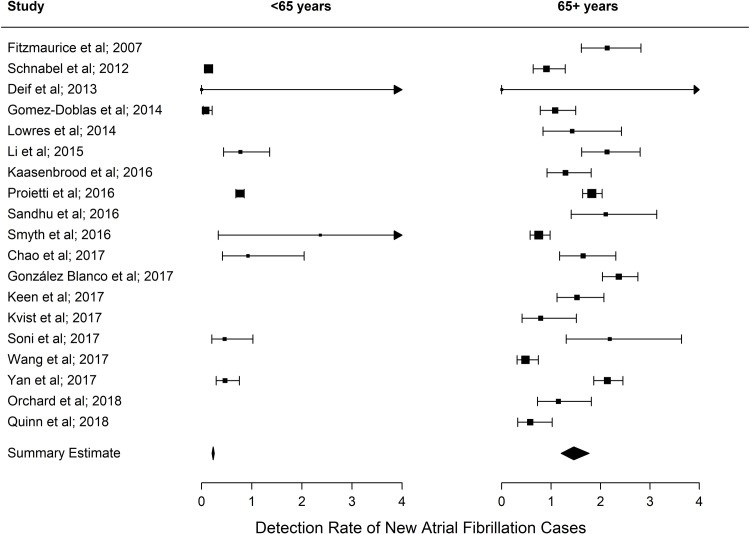
AF detection rate for <65 years and 65+ years.Summary estimates are calculated from the 18/19 studies that provided both gender and age for total numbers screened. AF, atrial fibrillation.